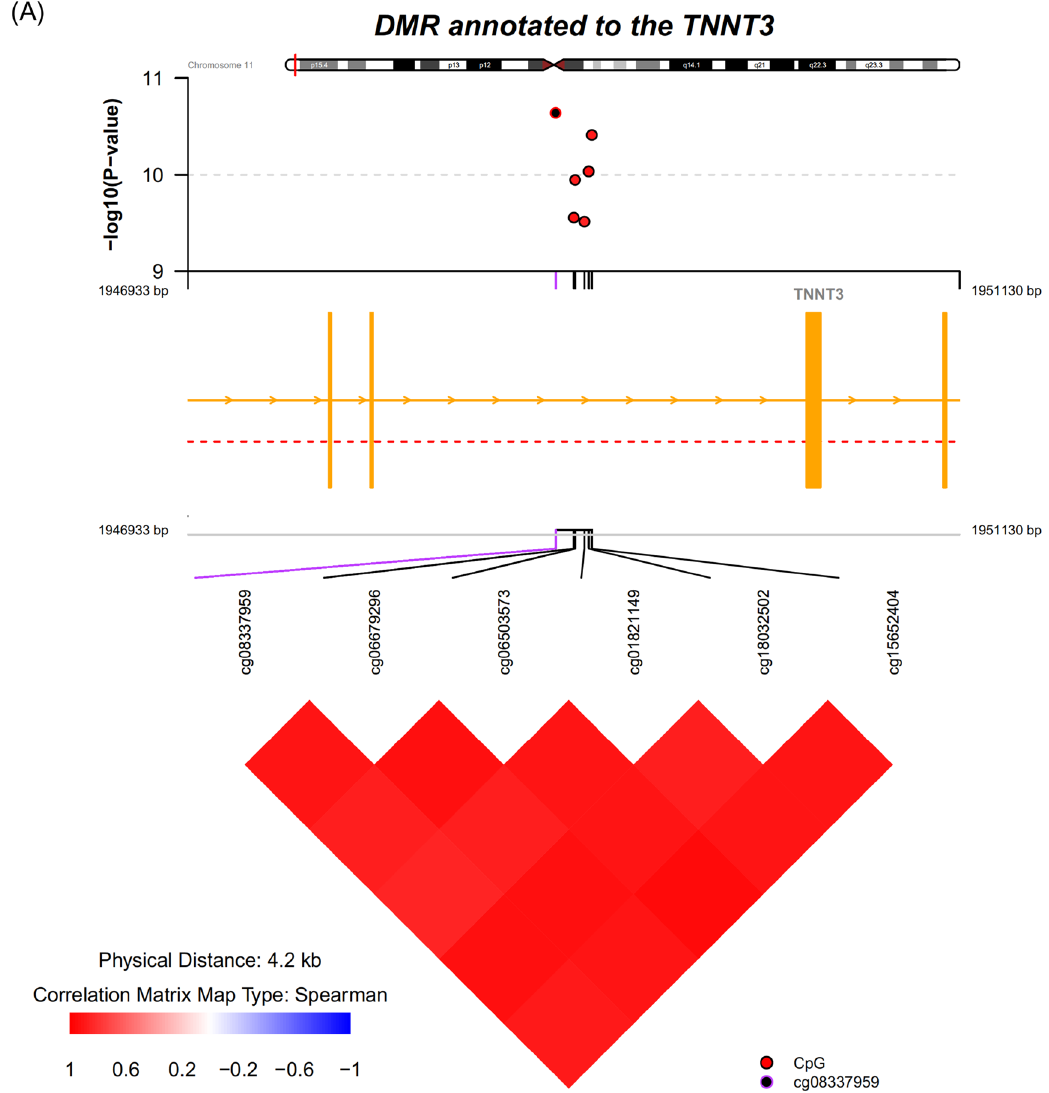
Figure 4. DMR annotated to TNNT3 ( A ), S100A13 ( B ) , and NRXN1 ( C ) association with the MDD case– control status. Top panel: individual CpG association P values; middle panel: gene structure; bottom panel: pairwise correlation between CpG sites in this DMR. CpG, cytosine-phosphate-guanine; DMR, differentially methylated